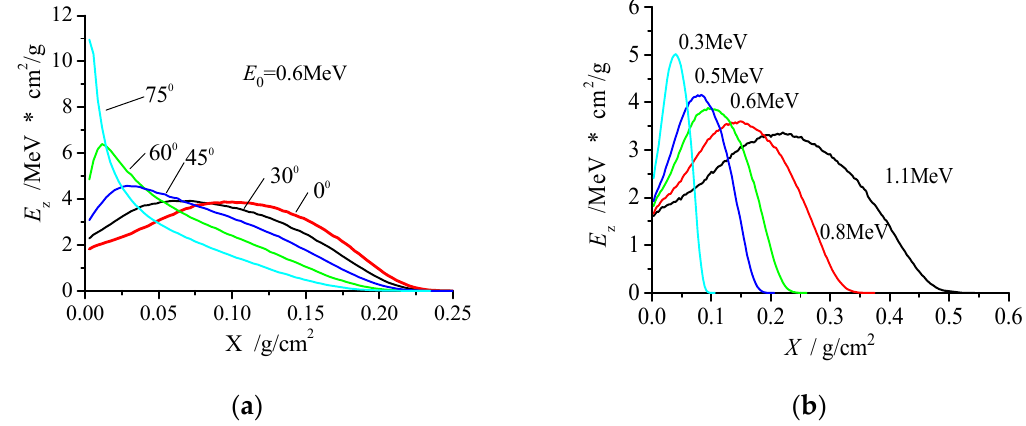
Figure 9. Energy deposition profile in carbon phenolic. ( a ) Different incident angles. ( b ) Different incident energies.